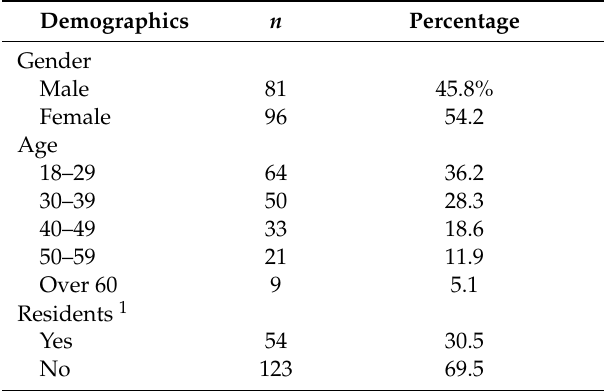
Table 2. Characteristics of visitors.